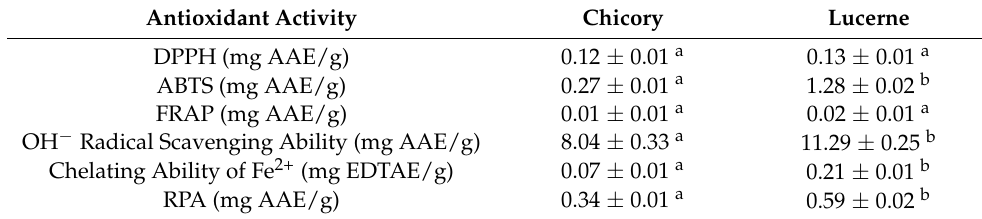
Table 2. Antioxidant activities of chicory and lucerne